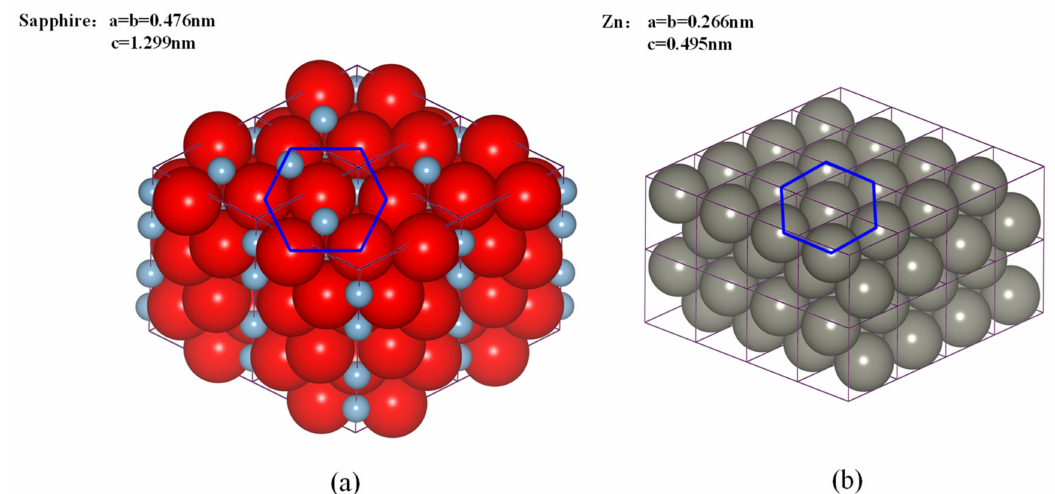
Figure 1. Schematic of the crystal arrangement of ( a ) sapphire (blue and red balls represent Al 3+ and O 2 − ions, respectively.) and ( b ) Zn,